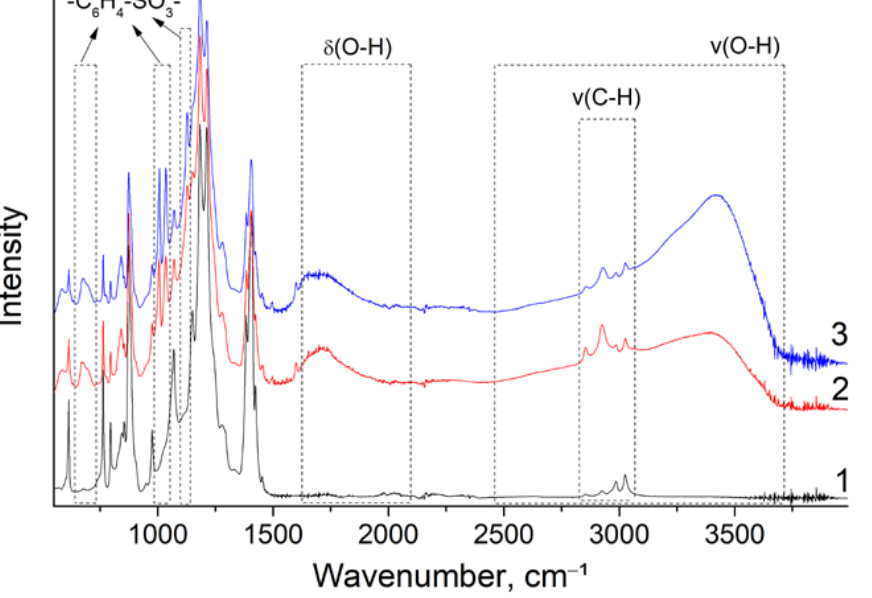
Figure 1. FTIR spectra of the initial PVDF film (1) and the obtained MCG-3 (2) and MCG-0 (3) membranes in proton form dried under air with an RH of 20–30%. The radiation-grafted membranes studied were designated as MCG-X, where X is the crosslinking degree equal to the divinylbenzene volume fraction in the styrene-divinylbenzene mixture.